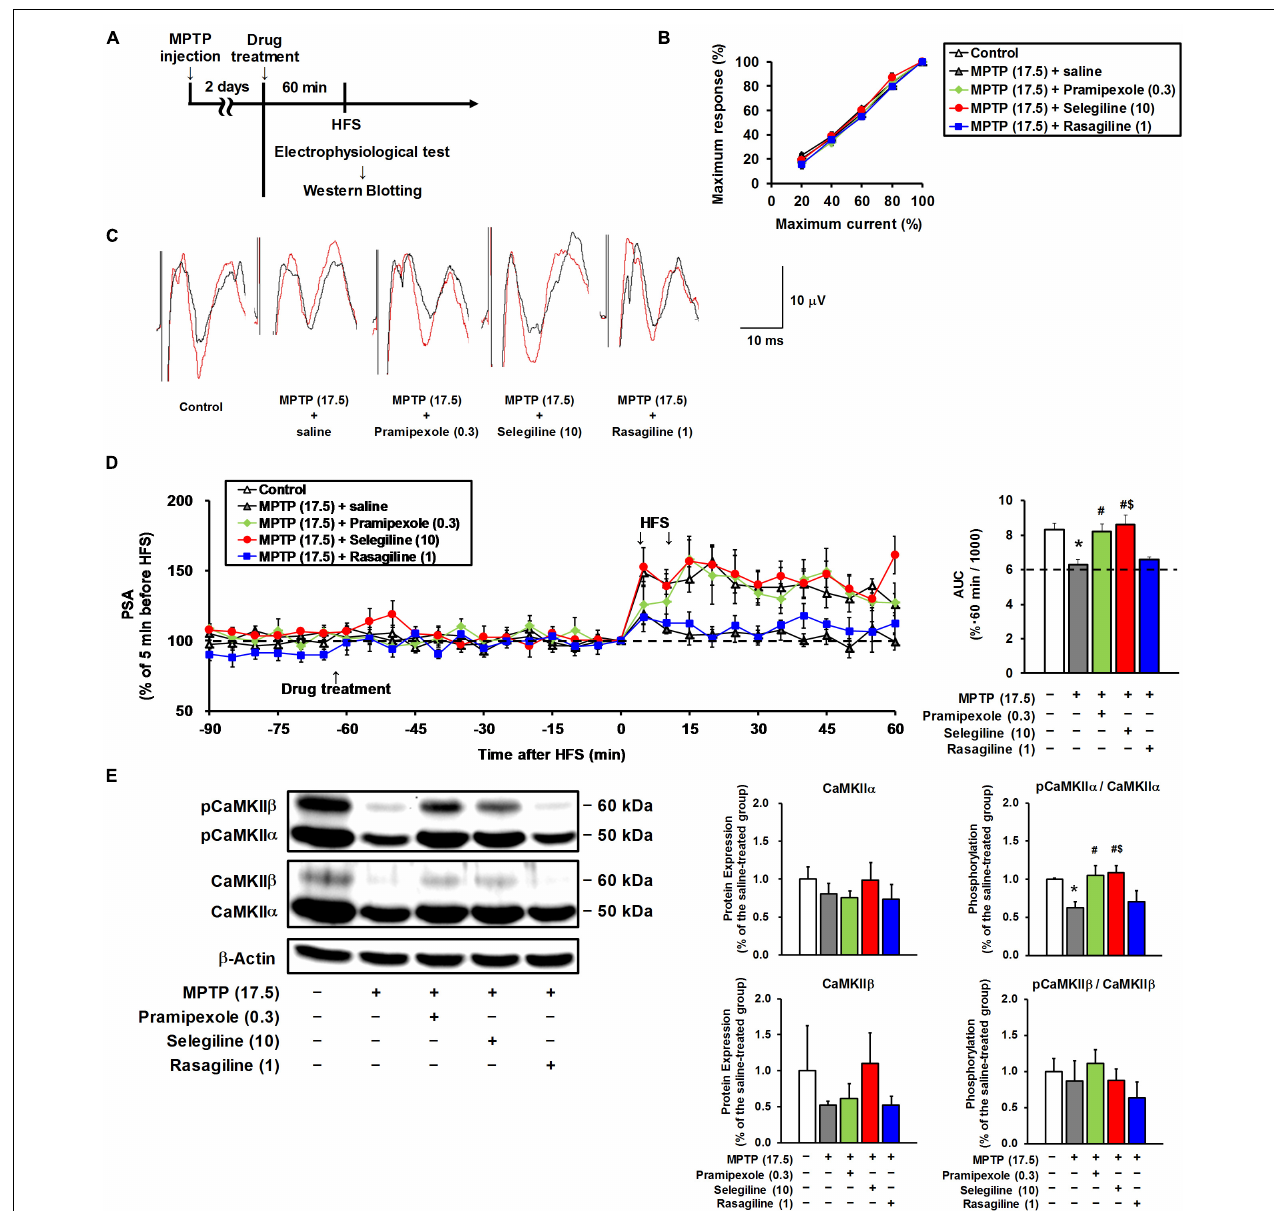
FIGURE 4 | Effects of selegiline (SEL), rasagiline (RAS), and pramipexole (PRX) on synaptic plasticity in the frontal cortex of MPTP mice. (A) Experimental timeline. (B) The input–output curves of population spike amplitude (PSA) in the hippocampus–medial prefrontal cortex pathway of the control mice and the MPTP mice prior to drug treatment. The groups were control ( n = 7), MPTP + saline ( n = 7), MPTP + PRX ( n = 5), MPTP + SEL ( n = 6), and MPTP + RAS ( n = 5). Values represent means ± SEM. 20% of maximum current: F ( 4 , 25 ) = 0.867, p = 0.497; 40%: F ( 4 , 25 ) = 0.354, p = 0.839; 60%: F ( 4 , 25 ) = 1.132, p = 0.364; 80%: F ( 4 , 25 ) = 1.419, p = 0.257. (C) Representative electrograms obtained before (black line) and after (red line) high-frequency stimulation (HFS). (D) Effects of SEL, RAS, and PRX on an HFS-induced sustainable increase in PSA. Left panel, changes in PSA; right panel, area under the curve (AUC) of PSA for 60 min after the first HFS. The groups were control ( n = 7), MPTP + saline ( n = 7), MPTP + PRX ( n = 5), MPTP + SEL ( n = 6), and MPTP + RAS ( n = 5). Values represent means ± SEM. ∗ p < 0.05 versus the control group. # p < 0.05 versus the MPTP + saline group. $ p < 0.05 versus the MPTP + RAS group (Tukey’s test), F ( 4 , 25 ) = 7.922, p < 0.05. (E) Effects of SEL, RAS, and PRX on protein expression of CaMKII α and CaMKII β , and their phosphorylation at threonine-286 in the frontal cortex. CaMKII α (50 kDa), CaMKII β (60 kDa), and β -actin (42 kDa). The groups were control ( n = 3), MPTP + saline ( n = 3), MPTP + PRX ( n = 3), MPTP + SEL ( n = 3), and MPTP + RAS ( n = 3). Values represent means ± standard deviation. ∗ p < 0.05 versus the control group. # p < 0.05 versus the MPTP + saline group. $ p < 0.05 versus the MPTP + RAS group (Tukey’s test), CaMKII α expression: F ( 4 , 10 ) = 1.765, p = 0.212; CaMKII α phosphorylation: F ( 4 , 10 ) = 13.286, p < 0.05; CaMKII β expression: F ( 4 , 10 ) = 1.860, p = 0.194; CaMKII β phosphorylation: F ( 4 , 10 ) = 2.165, p = 0.147. The numbers in parentheses indicate doses in